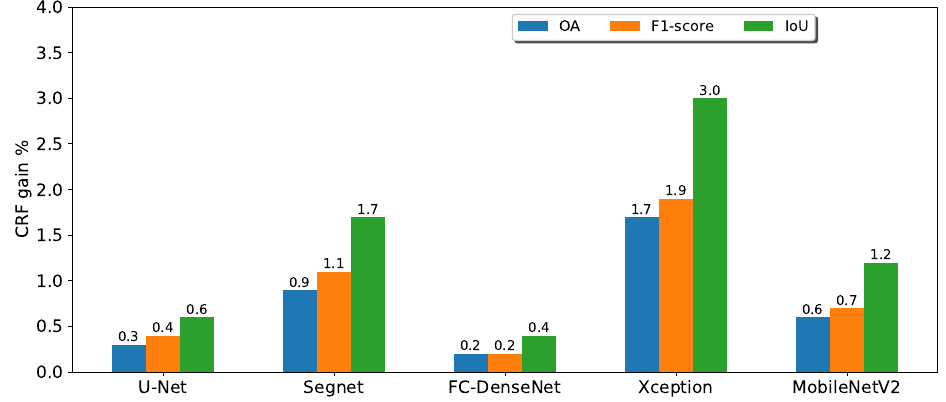
Figure 9. Performance gains due to CRF in terms of overall accuracy, F1-score, and IoU.